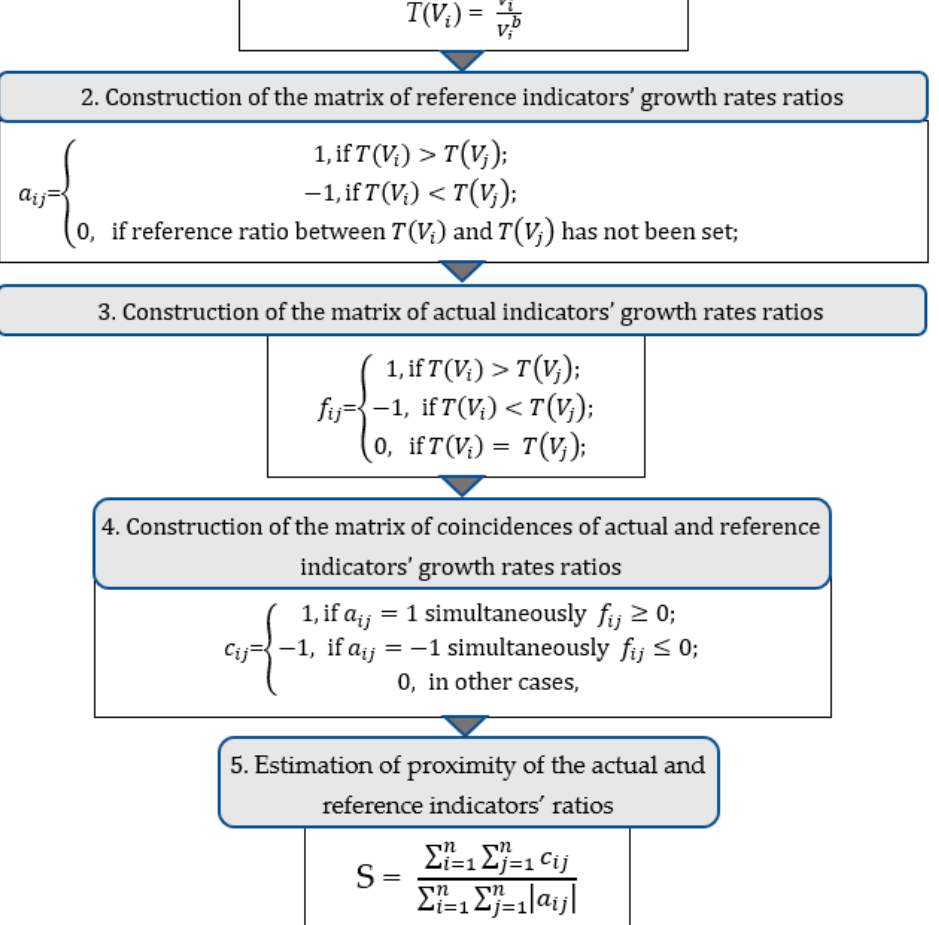
Figure 1. Algorithm for assessing CPS sustainability.